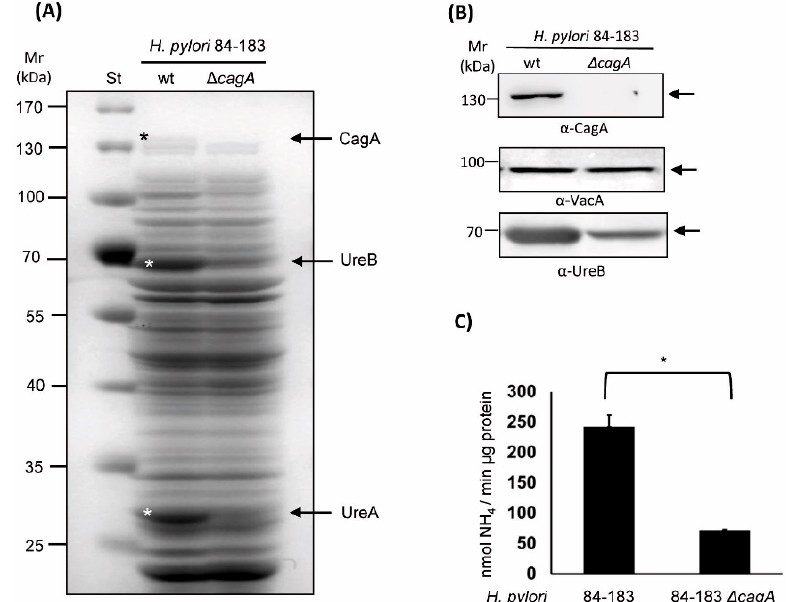
Figure 2. H. pylori 84-183 Δ cagA mutant revealed reduced urease expression levels. ( A ) Total protein extracts (80 µg) from H. pylori 84-183 parental and isogenic mutant strains were separated by SDS-PAGE (10%) and stained with Coomassie blue. A representative gel is shown. Asterisks and arrows indicate the positions of the urease subunits A and B, as well as the cytotoxin CagA (confirmed by mass spectrometry). To the left, molecular weight standards are indicated (130–25 kDa). A representative Western blot showing the absence of CagA, as well as reduced presence of the Urease A and B subunits in the H. pylori 84-183 mutant strain. VacA presence was analyzed as a loading control. ( B ) Immunodetection of UreB expression and ( C ) determination of urease activity in protein extracts from 84-183 wild type (wt) and Δ cagA mutant strains. Bars are indicative of urease activity determined as NH 4 /min/µg protein (means ± SEM, n = 3, * p ≤ 0.05).